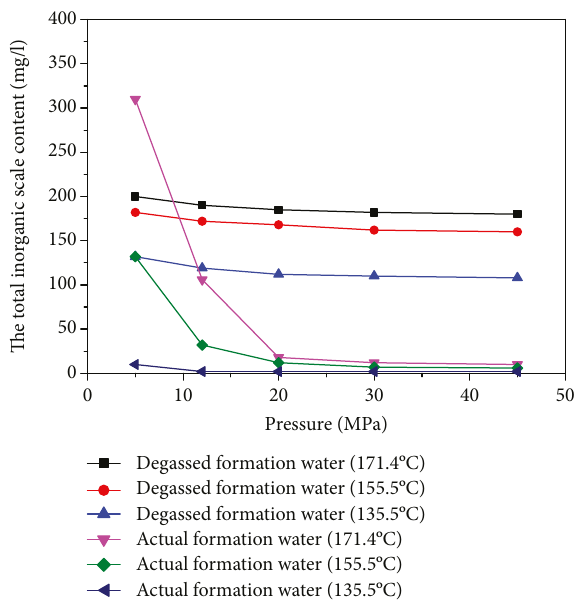
Figure 5: Contrast curves of the scaling amount of BS8 ’ s degassed formation water and the actual formation fl